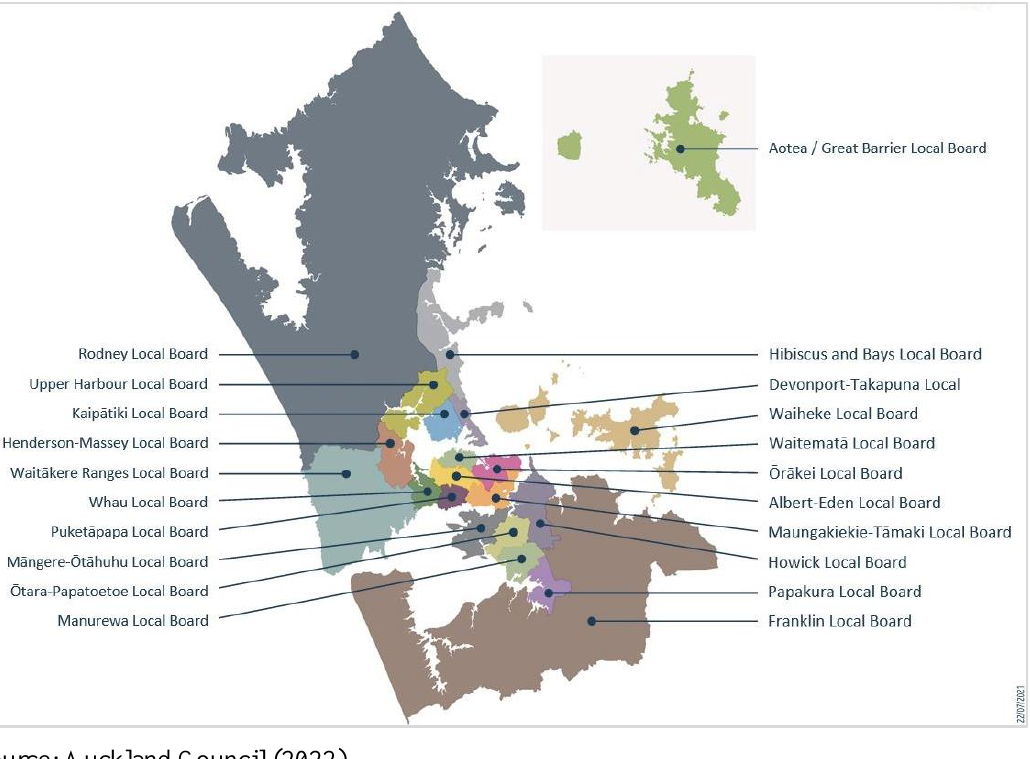
Source: Auckland Council